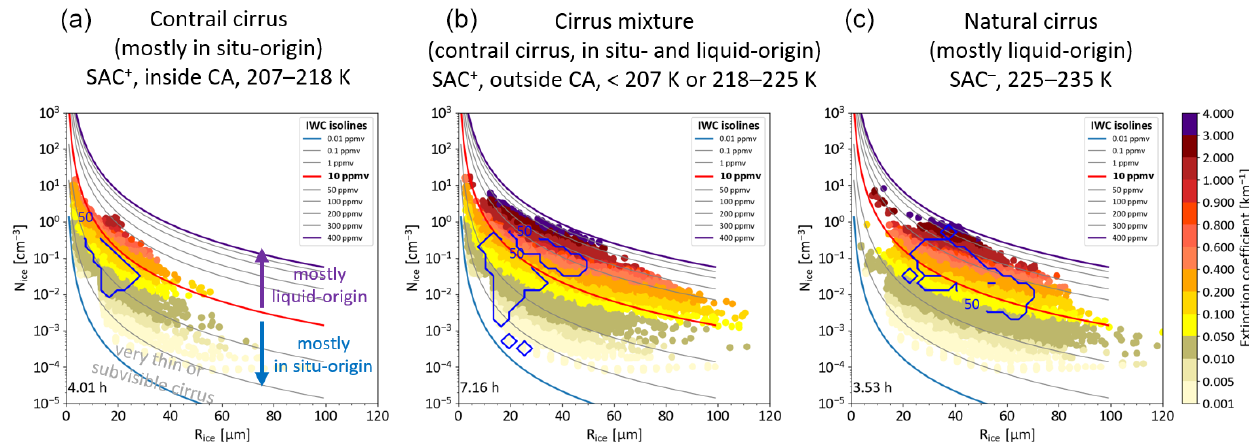
Figure 11. Ice crystal number concentration N ice vs. mass mean radius R ice colour-coded with extinction coefficient Ext (unit: km − 1 ) of ice particles. Ice water content (IWC) isolines in relation to N ice and R ice are also plotted. (a) The contrail cirrus that fulfil the Schmidt– Appleman criterion (SAC) inside the cruising altitude (CA; ambient pressure 200–245hPa, ambient temperature 207–218K), also identified as in situ-origin cirrus; median: N ice = 0.045cm − 3 , R ice = 16.6µm, IWC = 3.5ppmv, Ext =∼ 0.056km − 1 . (b) The cirrus mixture (fulfilling SAC and outside the CA range), which is a mixture of contrail cirrus and in situ- and liquid-origin natural cirrus; median: N ice = 0.038cm − 3 , R ice = 24.1µm, IWC = 8.3ppmv, Ext =∼ 0.096km − 1 . (c) the natural cirrus of liquid-origin (not fulfilling SAC and below the CA range); median: N ice = 0.018cm − 3 , R ice = 42.4µm, IWC = 21.7ppmv, Ext =∼ 0.137km − 1 . The 50% (blue) contour encloses 50% the most fre- quently occurring ice crystals. The total sampling hours of each cirrus dataset at 1Hz sampling frequency are inserted in the lower left corners of the